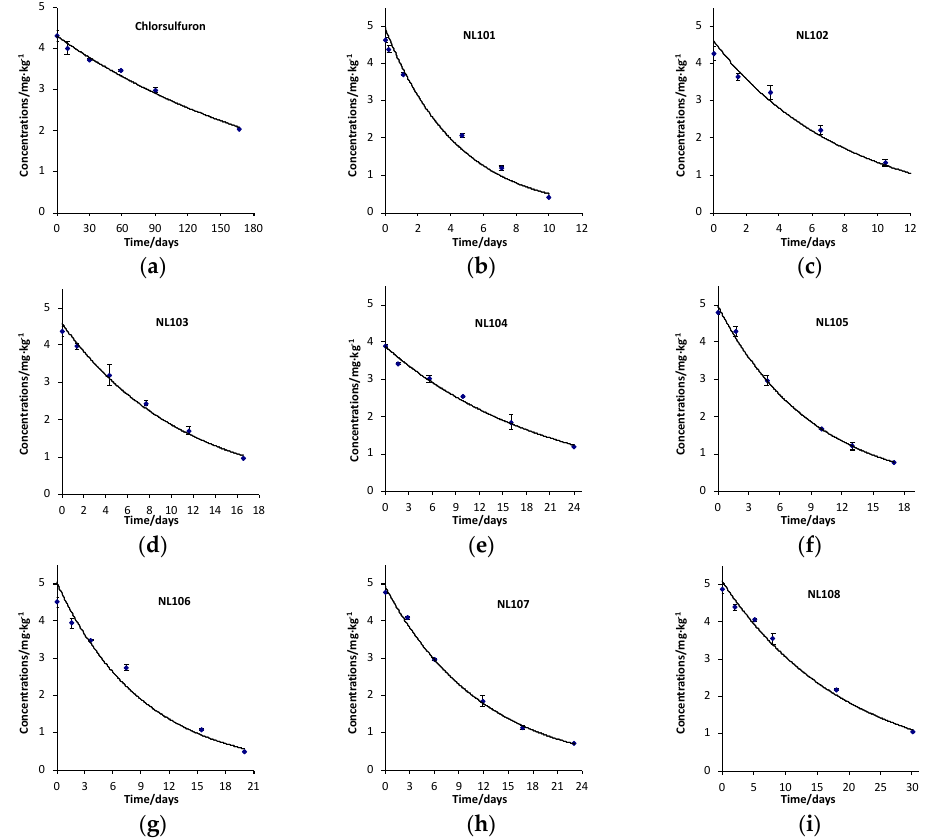
Figure 4. Degradation curve of target compounds (alkaline soil, pH 8.39). ( a – i ): Chlorsulfuron,